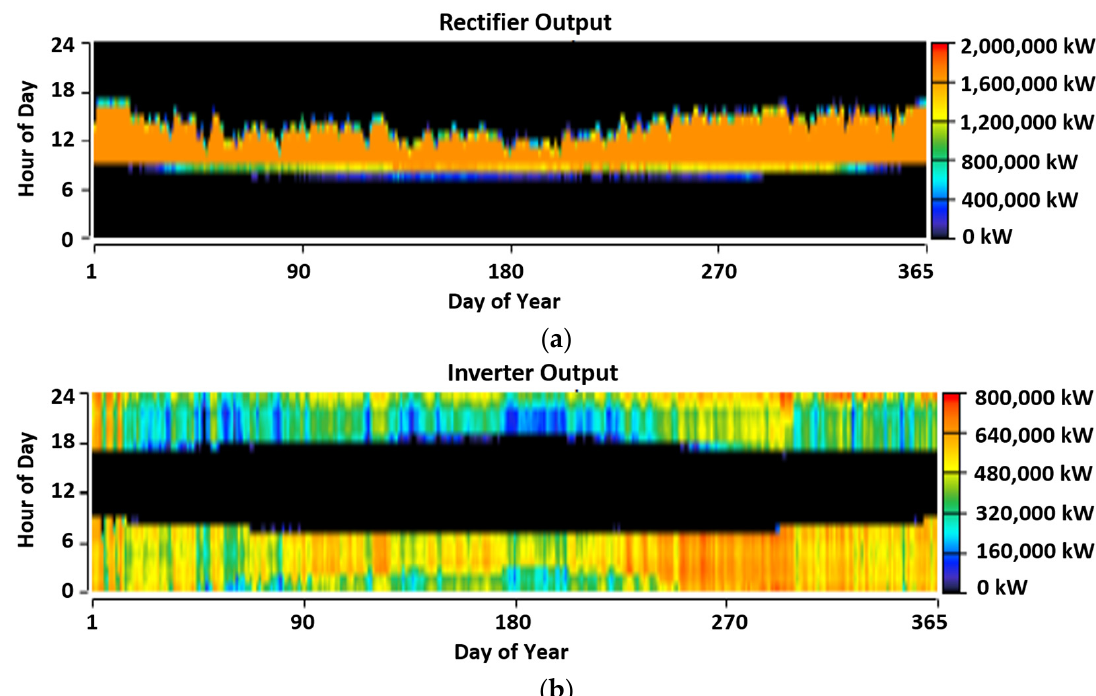
Figure 11. Yearly performance of the reverse pumping system. ( a ) Pumping; ( b ) turbination.